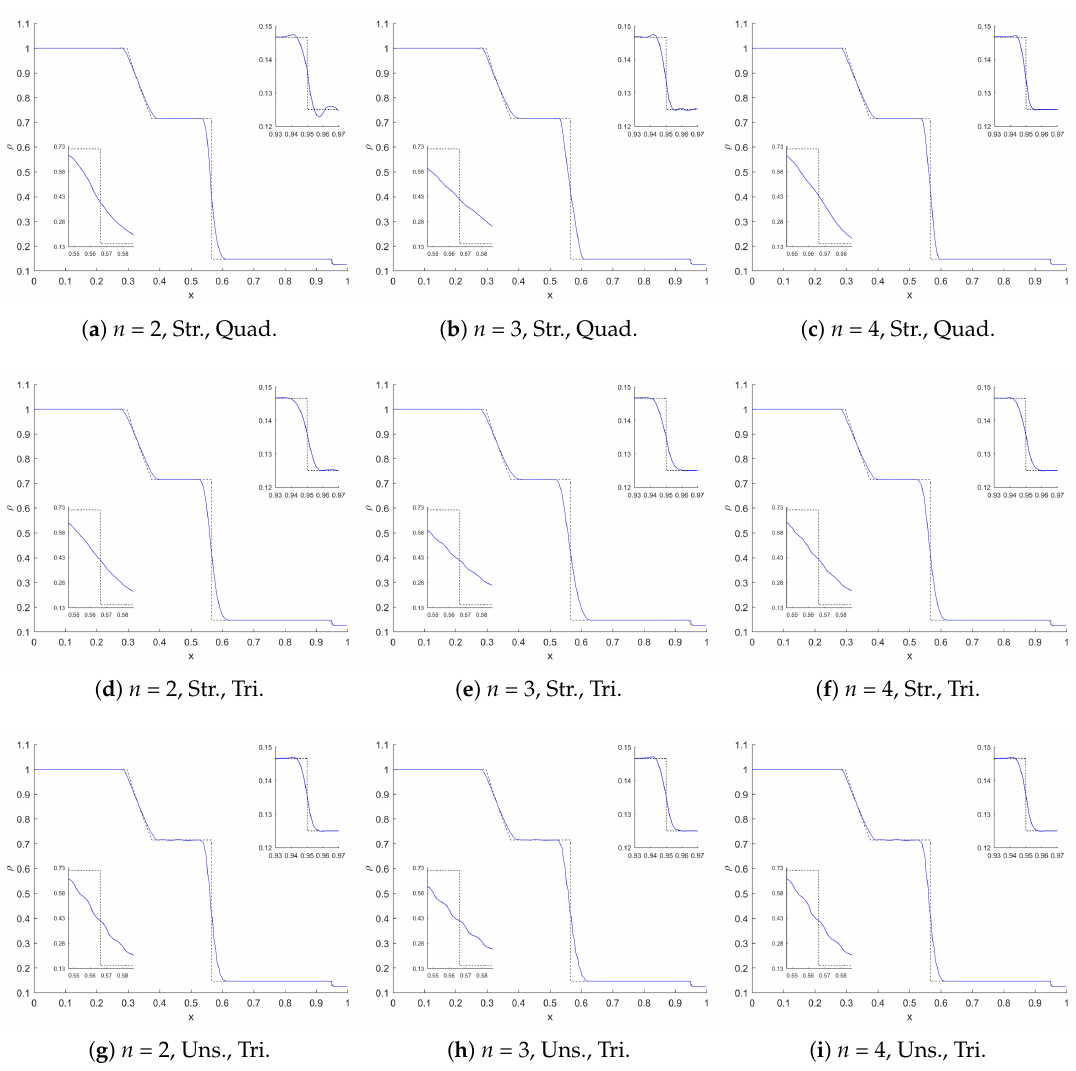
Figure 4. Two-dimensional shock tube problem with initial pressure ratio 2, various polynomial orders, and different types of grids. In each plot, the top-right inset figure is the result near the shock wave and the bottom-left inset figure is the result near the contact discontinuity.